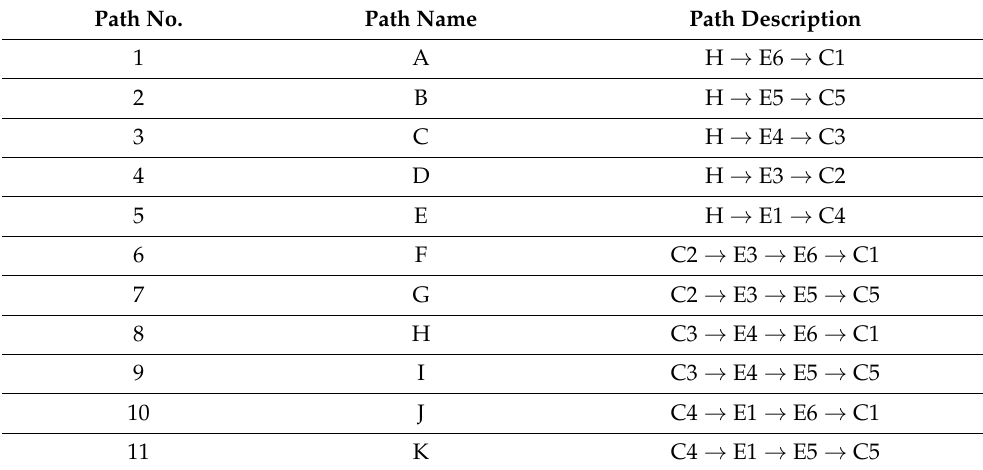
Table 3. Individual utility paths in the existing HEN case. Path No. Path Name Path